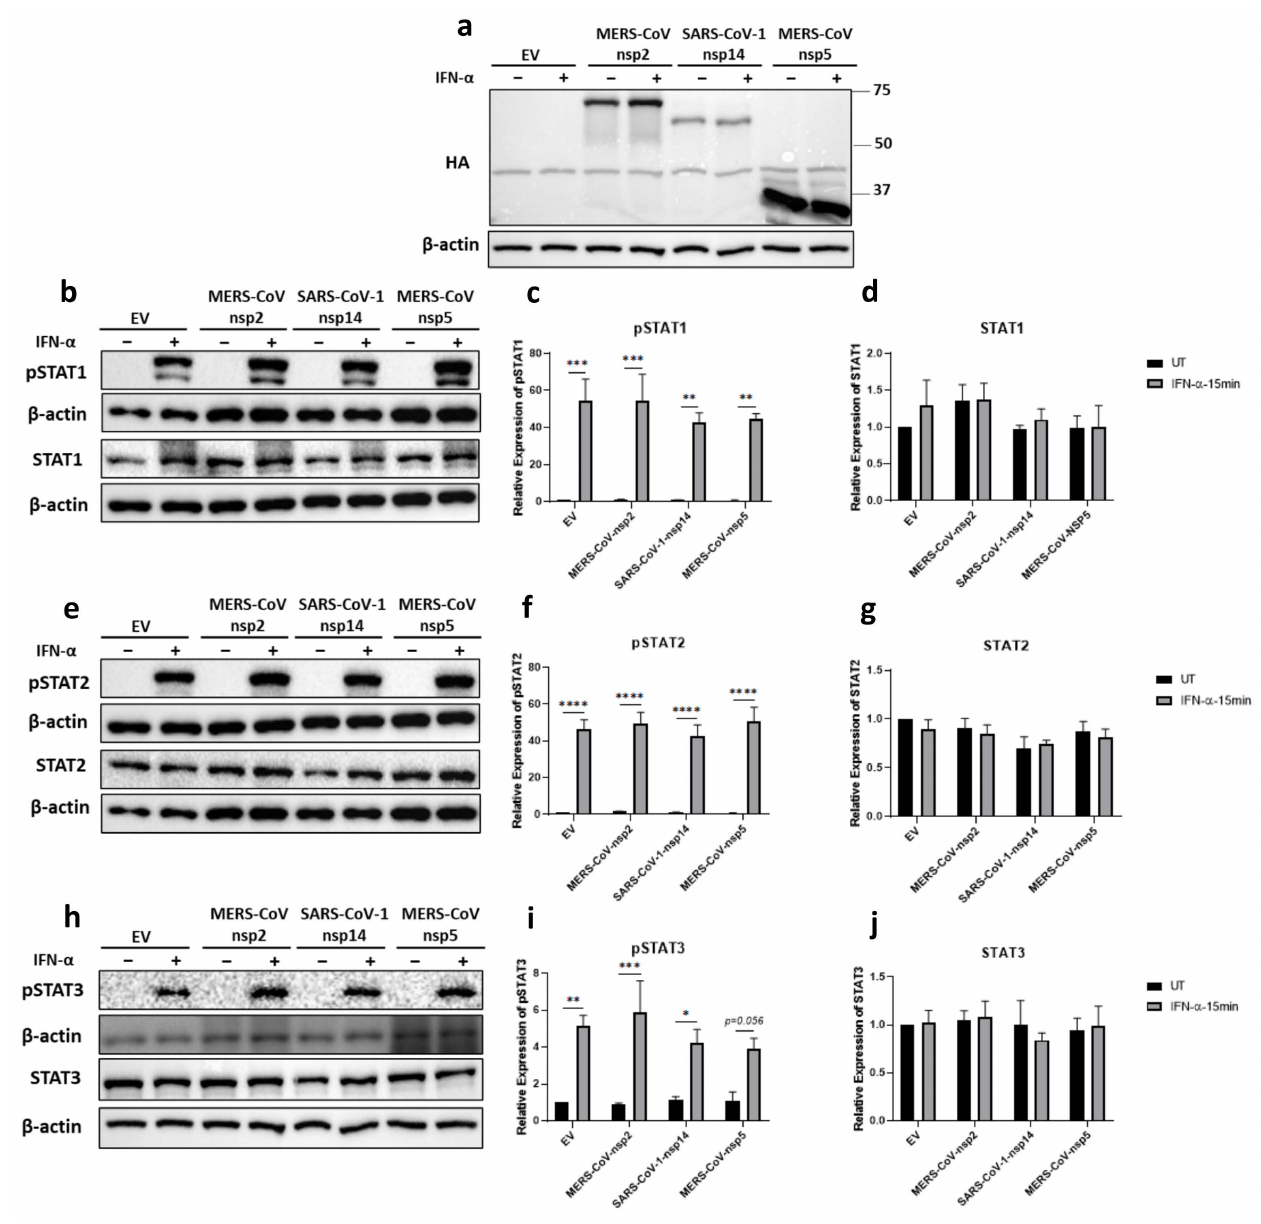
Figure 3. MERS-CoV-nsp2 and SARS-CoV-1-nsp14 expression have no effect on total STAT levels nor their phosphorylation in HEK293T cells. HEK293T were transfected with Empty Vector (EV) or HA-tagged MERS-CoV-nsp2, SARS-CoV-1-nsp14, or MERS-CoV-nsp5. After 24 h, cells were treated with IFN- α (1000 U/mL) for 15 min. Lysates were generated and subjected to immunoblotting with antibodies for ( a ) HA; ( b ) pSTAT1 and STAT1; ( e ) pSTAT2 and STAT2; or ( h ) pSTAT3, STAT3, and HA. All blots were also probed with a β -actin antibody. (N.B pSTAT1 and STAT2 were probed in one membrane and therefore share the same β -actin, and the pSTAT2 and STAT1 were probed in one membrane and therefore share the same β -actin). Densitometric analysis of ( c ) pSTAT1, ( d )